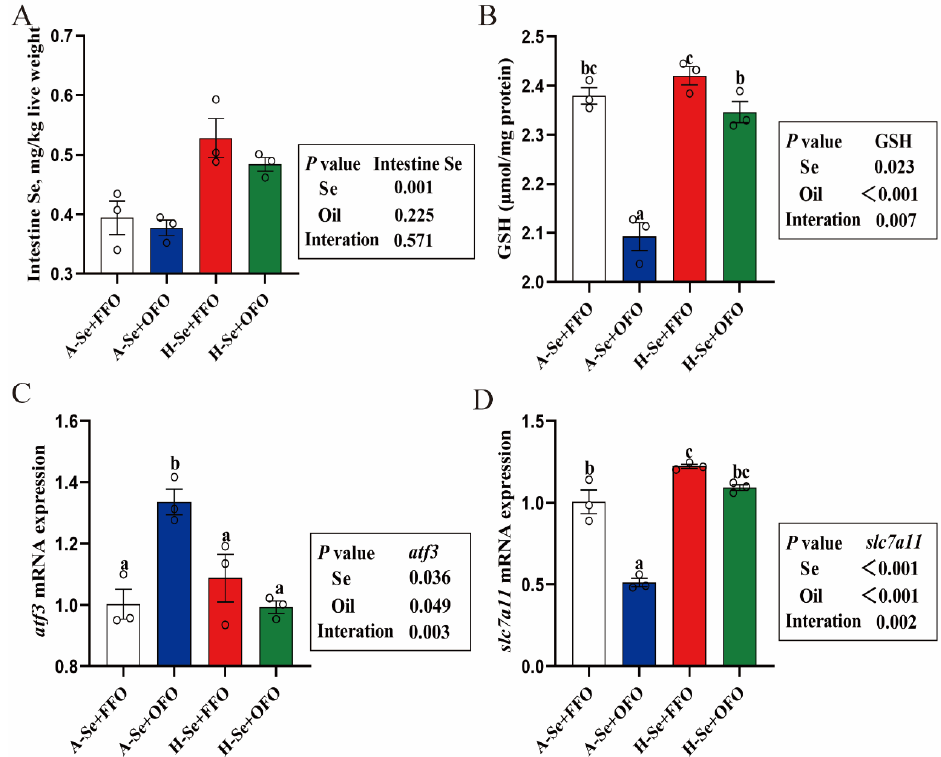
Figure 5. Effect of selenium and oxidized fish oil on Se content and GSH content in the intestine of yellow catfish. ( A ) Se content. ( B ) GSH. ( C ) The expression of atf3 mRNA. ( D ) The expression of slc7a11 mRNA. All data were mean ± SEM ( n = 3). “a–c” indicate significant differences at p < 0.05. p value was calculated by two ‐ way ANOVA.